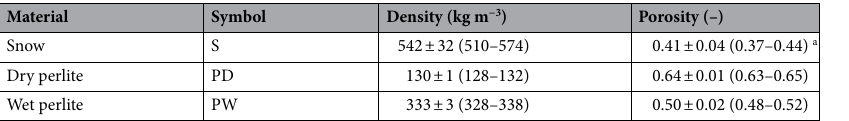
Table 1. Basic properties of the tested materials. The values are presented as mean ± standard deviation and range (minimum–maximum). a The porosity of the snow was calculated from its density 23 .